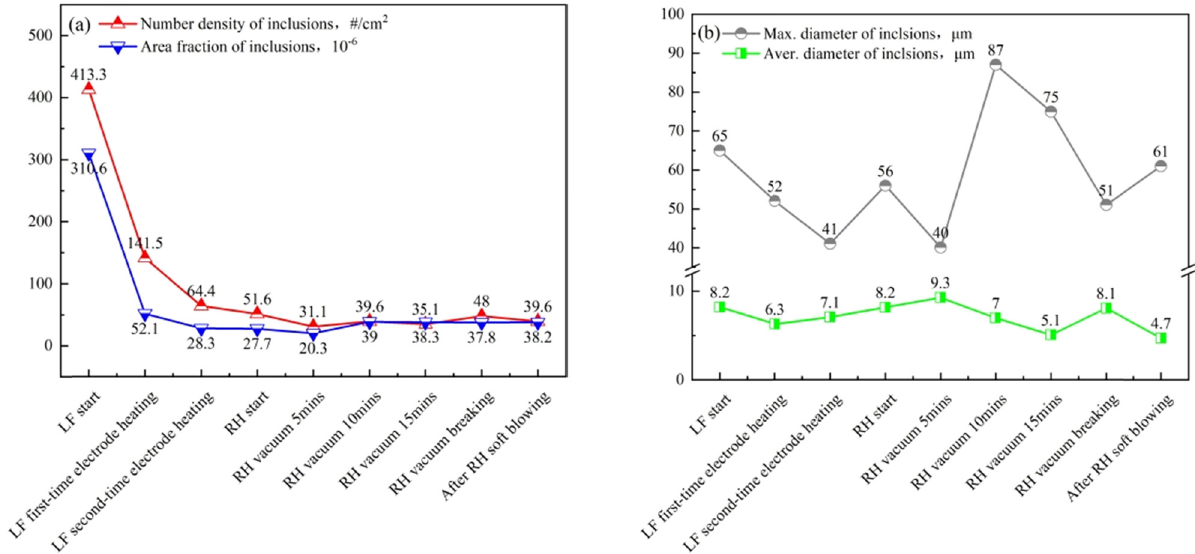
Figure 6: Number density, area fraction, average length and maximum length of inclusions at di ff erent stages during the LF – RH re fi ning process in heavy rail steel: ( a ) number density and area fraction and ( b ) average and maximum